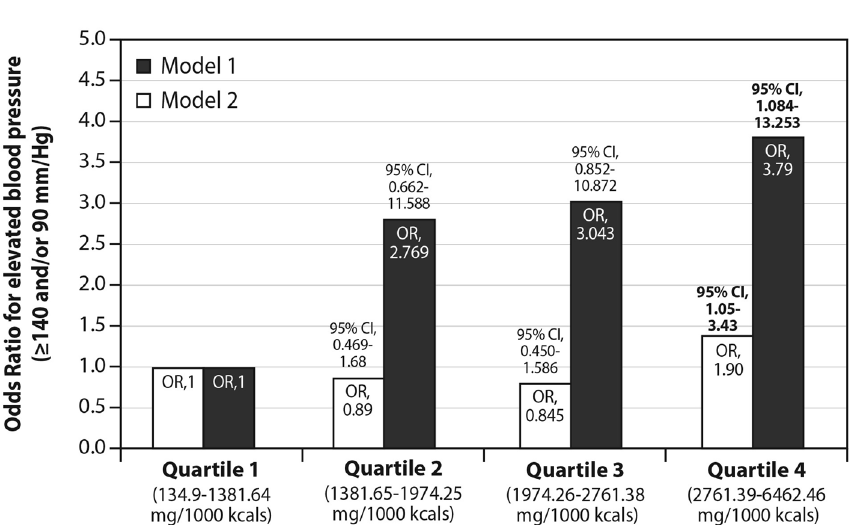
Figure 3. The independent association between sodium excretion (Model 1, solid bars) as well as sodium density (excretion per 1000 kcals; Model 2, open bars) and measured hypertension (≥ 140 and/or 90 mm/Hg). Results from a multivariate logistic regression indicating the higher odds for elevated blood pressure (≥ 140 and/ or 90 mm/Hg) as a function of highest sodium excretion (per 1000 Kcals)—independent of other explanatory variables (age, sex, BMI categories, coronary heart disease, diabetes, ideal physical activity and smoking status). As compared to the lowest level (Q1), the highest level of sodium excretion (represented as Q4) was significantly and positively associated with higher odds for hypertension. Adjusted for: the presence of diabetes (0 = no; 1 = yes), coronary heart disease (0 = no; 1 = yes), age (up to 43.9 = 0; 44–65 = 1), smoking (0 = no or in the past; 1 = yes), ideal physical activity (As recommended by the American College of Sports Medicine [ACSM]- 150 weekly minutes or more of moderate intensity or 75 weekly minutes of intense physical activity; 0 = no; 1 = yes) and BMI categories (1. up to 18.5 2. 18.5–24.99 3. 25–29.99 4. 30–34.99 5. above or equal 35 [category 1 = reference]) and sex (0 = female; 1 =